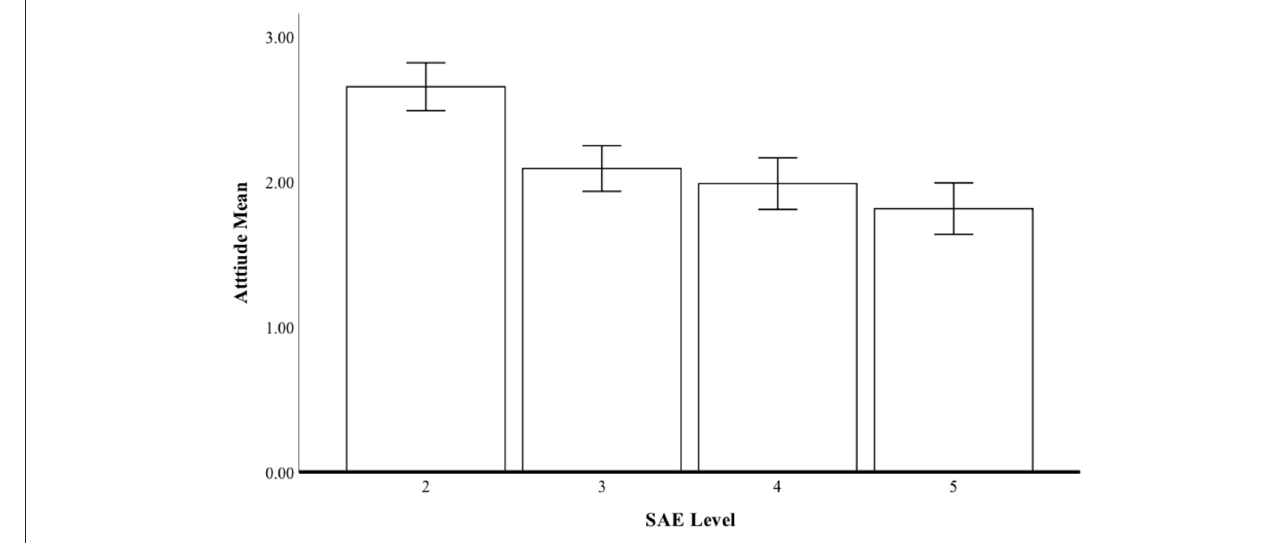
FIGURE 3 | Preference for the vehicles (SAE levels 2–5).